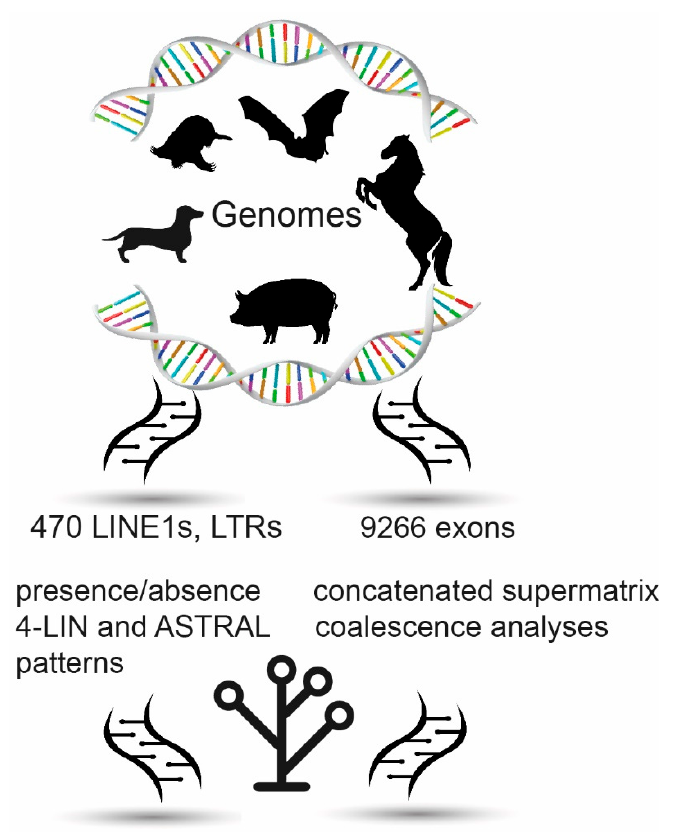
Figure 1. Schematic representation of the applied phylogenetic approaches. Retrotransposon analyses of 470 diagnostic LINE1 and LTR presence/absence patterns ( left ) and exon sequence for concatenated and coalescence analyses ( right ).